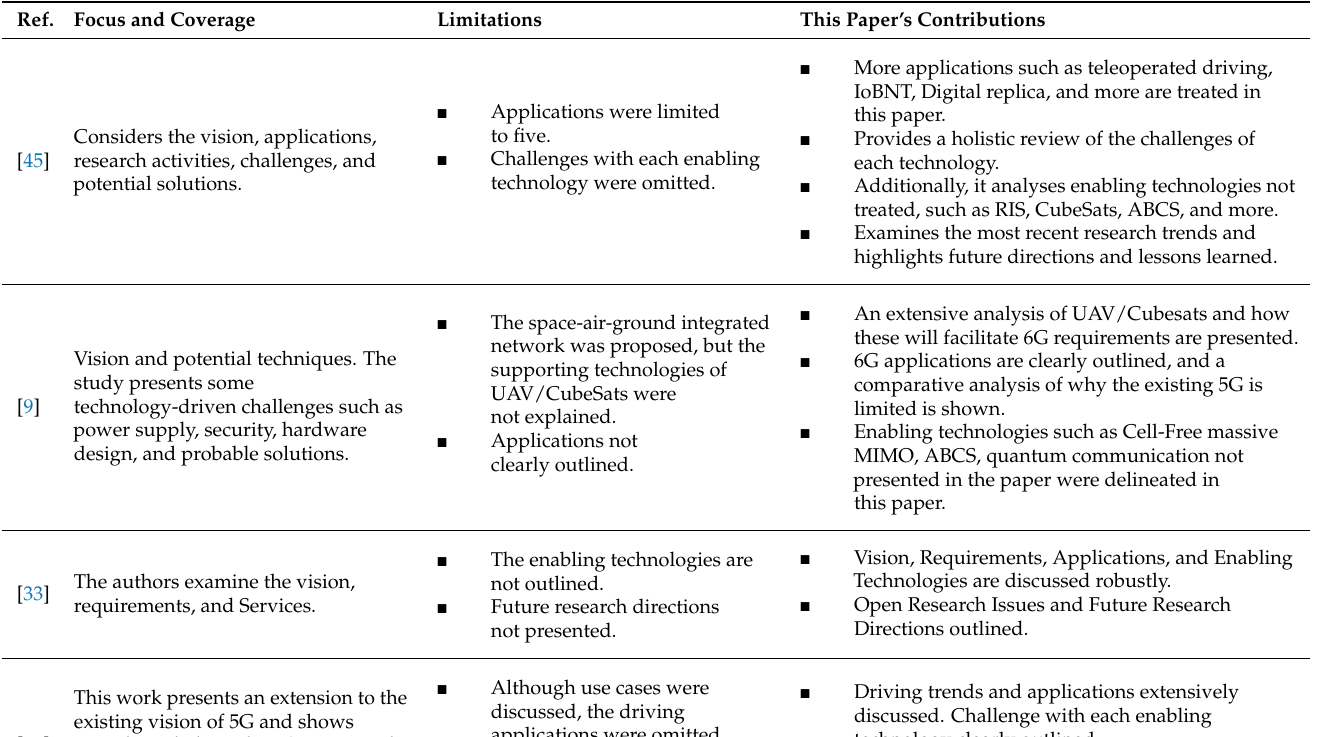
Table 1. Limitations of some related surveys and our